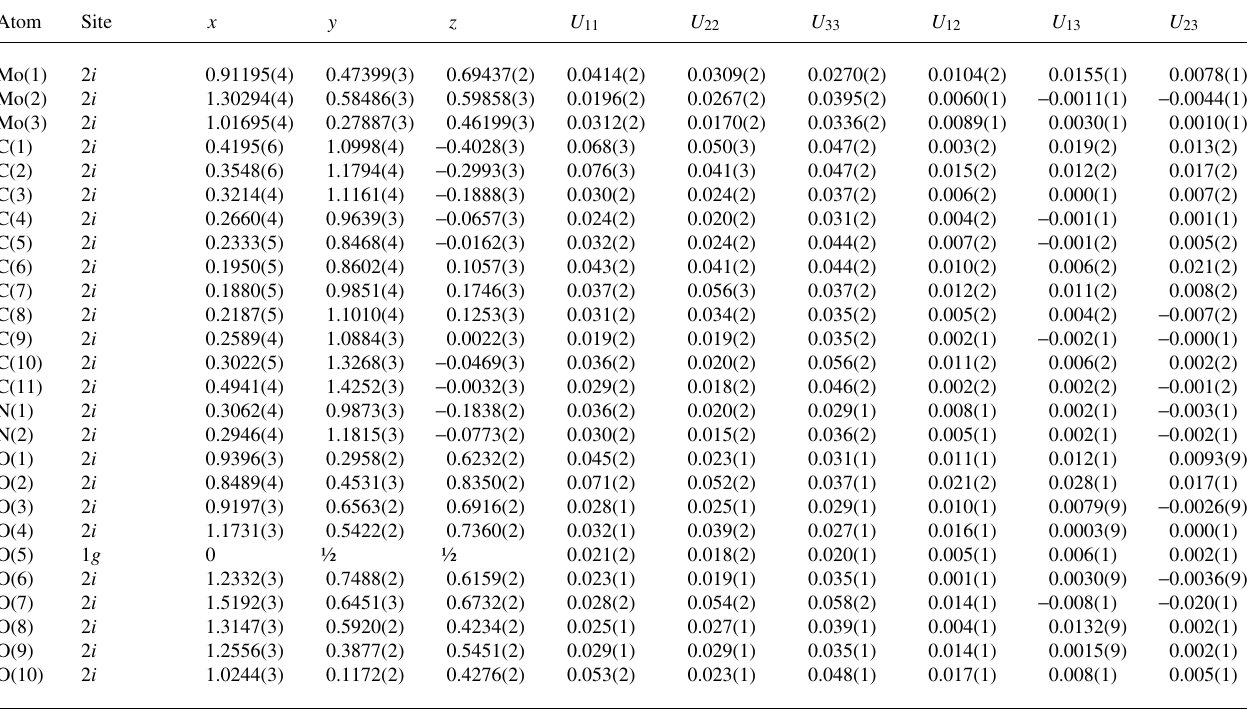
Table 3. Atomic coordinates and displacement parameters (in Å 2 )